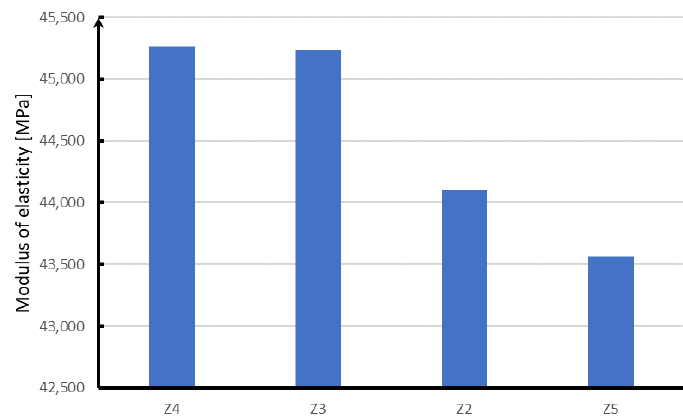
Figure 18. Results of the elastic modulus test. Figure 18 . Results of the elastic modulus test. Figure 18 . Results of the elastic modulus test.